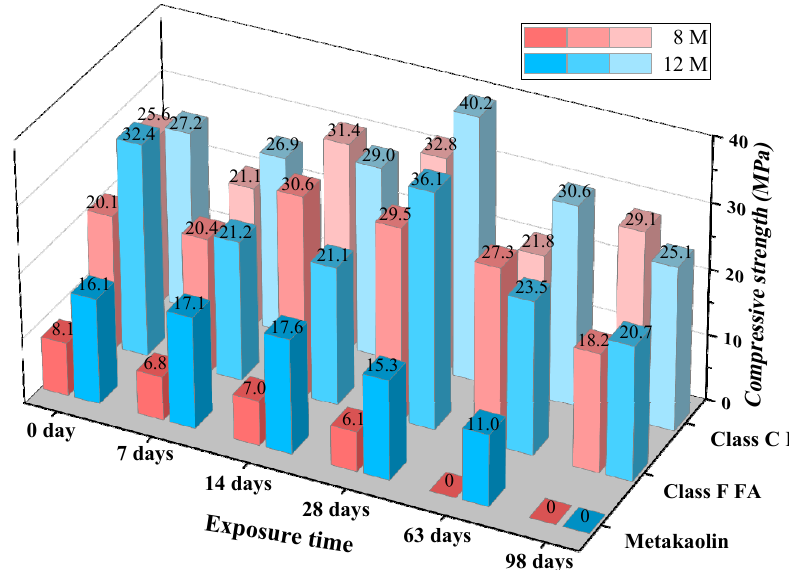
Figure 6. Compressive strength of GPC exposed to sulfuric acid solution.